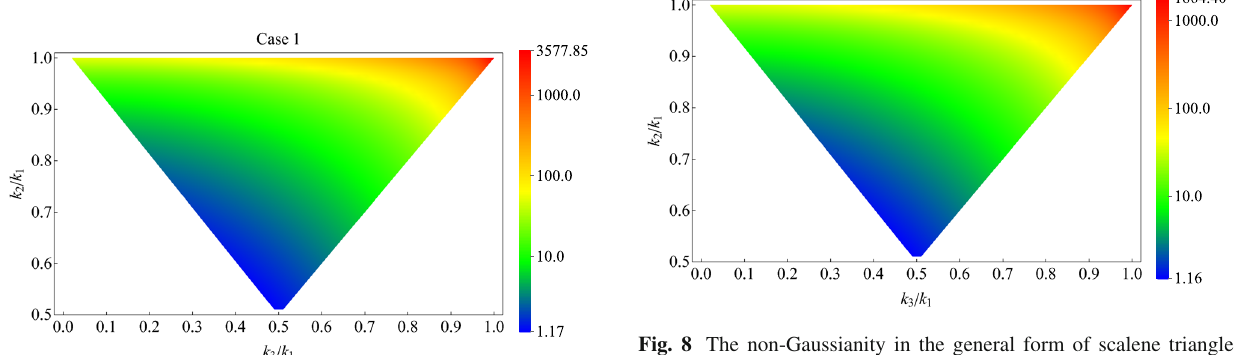
Fig. 8 The non-Gaussianity in the general form of scalene triangle configuration for Case